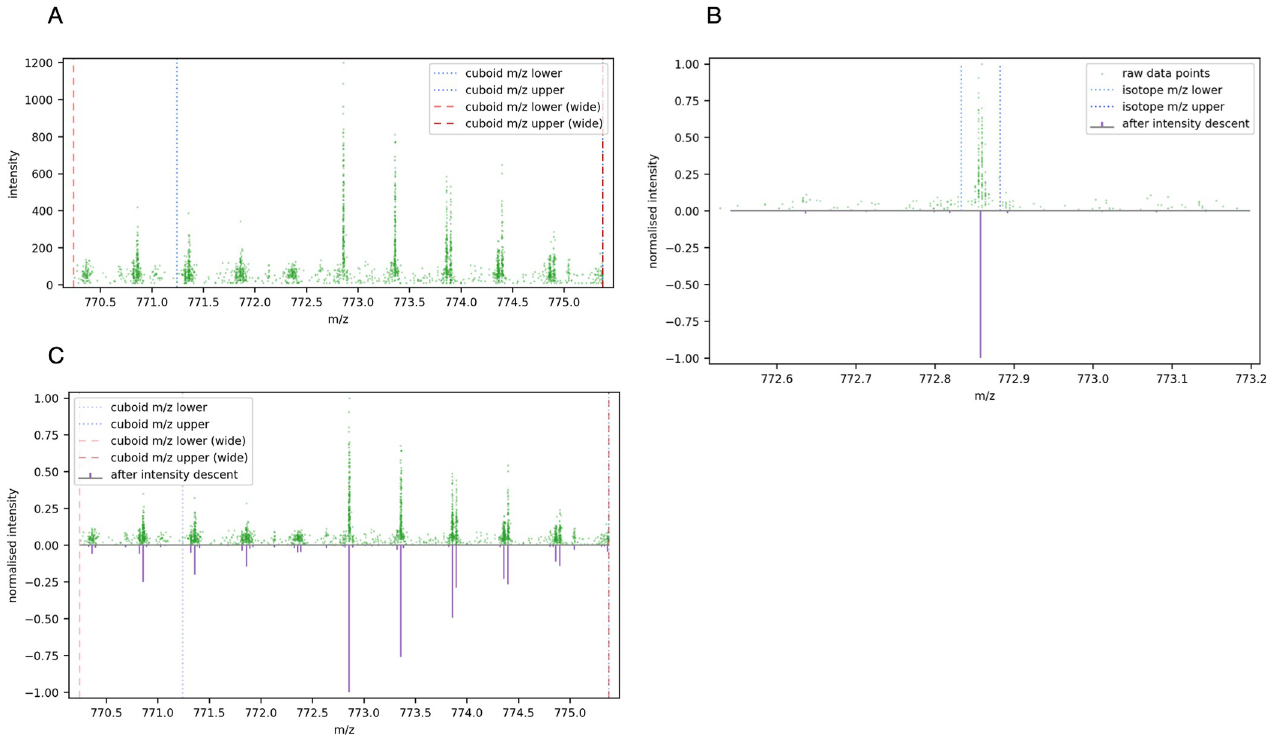
Fig 3. Resolving raw points to isotopic peaks. (A) Raw MS1 spectra within a precursor cuboid defined by a range of m/z, RT, and collisional cross-section values. (B) Comparing ms1 spectra before and after intensity descent for a selected peak within the precursor cuboid. The 3 σ bounds on each side are shown; the raw points within these bounds were summed and centroid with intensity weighting to form the single peak shown underneath. (C) Comparing the complete ms1 spectra for a selected precursor cuboid, before and after intensity descent.